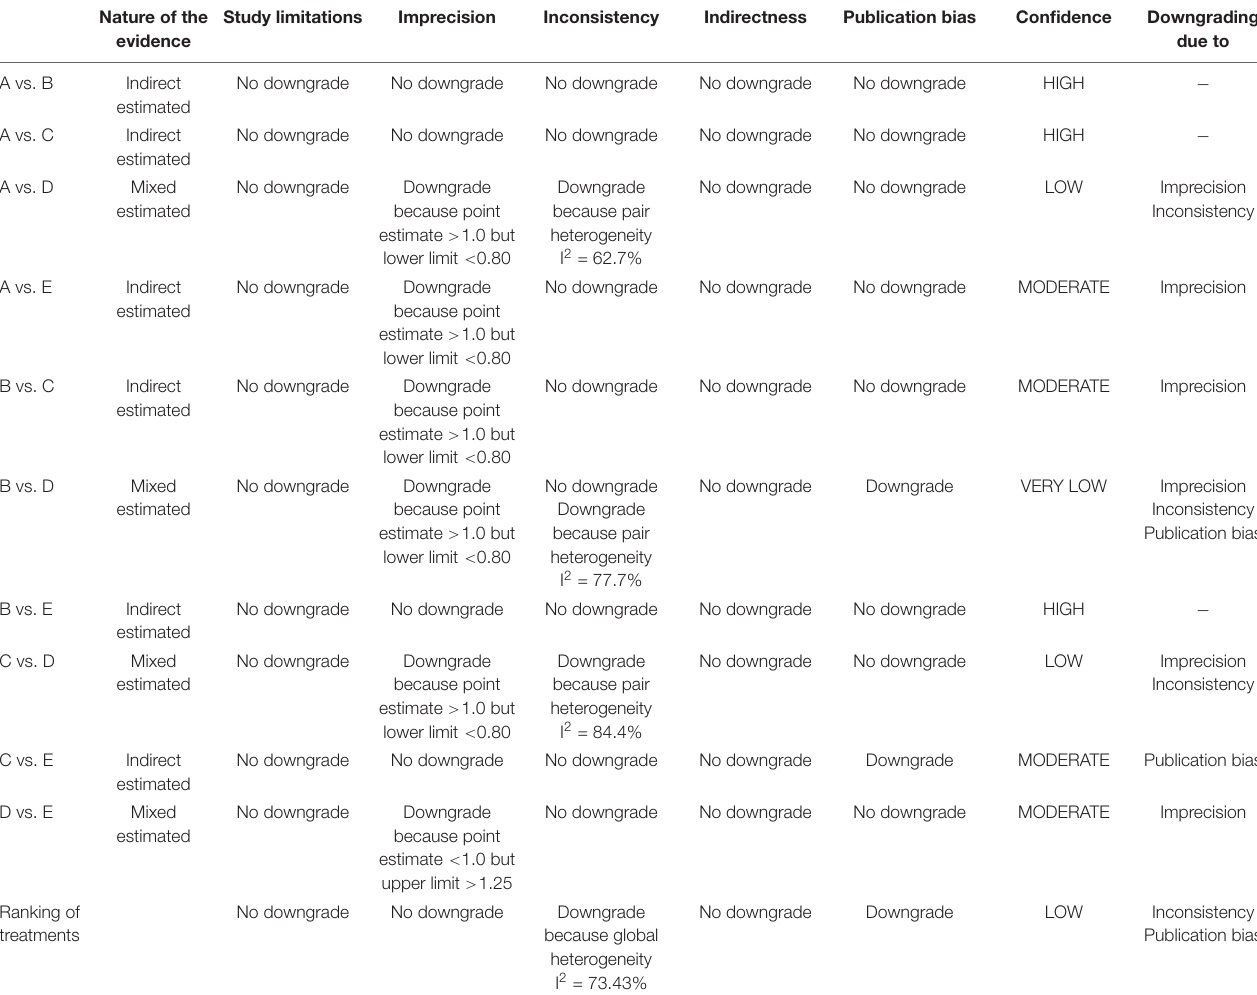
TABLE 6 | Result of GRADE for nosocomial